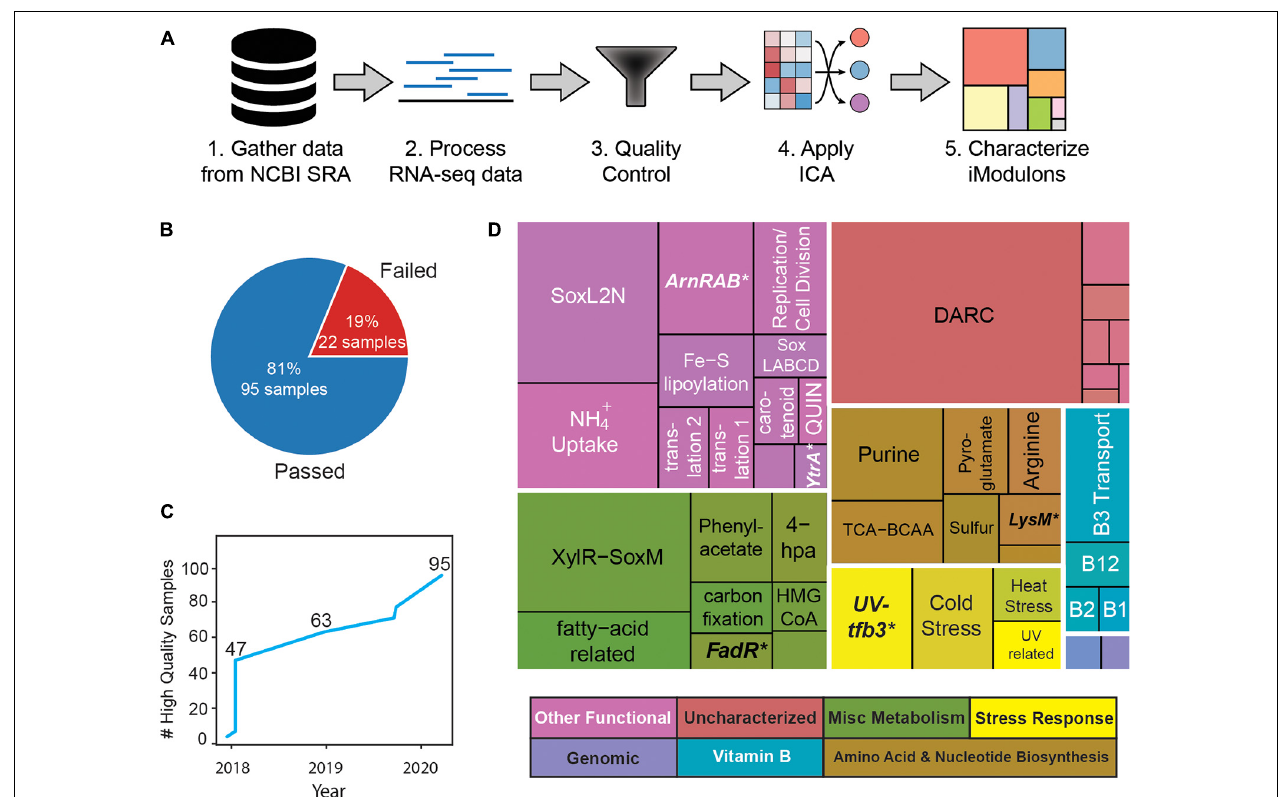
FIGURE 1 | Overview of compiled S. acidocaldarius RNA-seq compendium and its iModulon characterization. (A) Graphical representation of the PyModulon ICA workflow [adapted from Sastry et al. (2021b)]. (B) Number of samples that passed quality control. (C) Number of high-quality RNA-seq expression profiles for S. acidocaldarius in NCBI SRA over time. (D) Treemap of iModulons generated from the curated RNA-seq compendium. Sizes are representative of variance explained by iModulon (total 72%). Boldface and asterisk indicate that the corresponding iModulon recapitulates a known